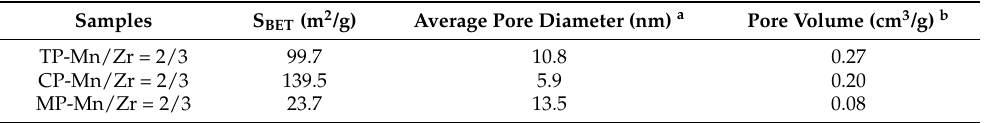
Table 2. The surface area, average pore diameter, and pore volume of TP-Mn2Zr3, CP-Mn2Zr3, and MP-Mn2Zr3 catalysts.